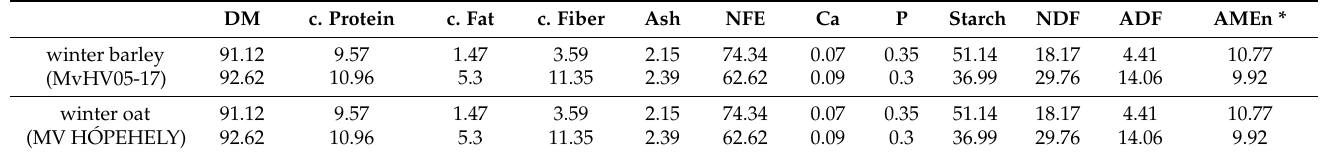
Table 1. Chemical composition of barley and oats.